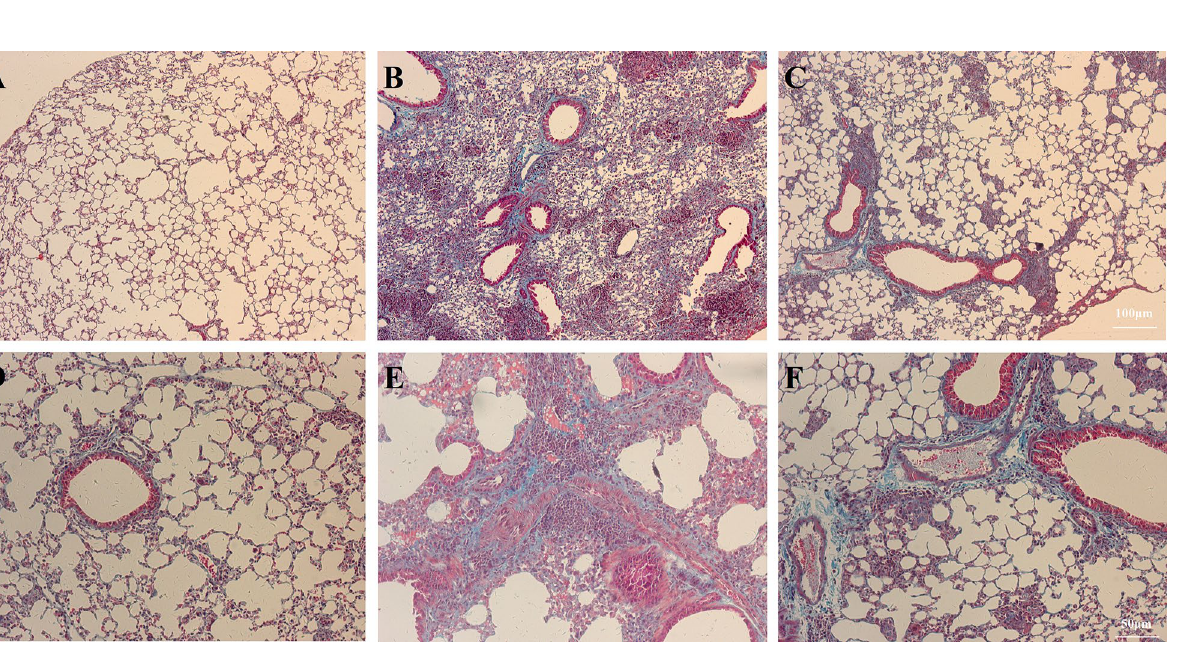
Figure 7. BM-MSCs improved LPS-induced pulmonary fibrosis at 24 h after LPS treatment. ( A ) Sham group. ( B ) LPS group. ( C ) LPS + MSC group. Mason staining revealed the degree of pulmonary fibrosis. ( A – C , ×100 magnification. D – F , ×200